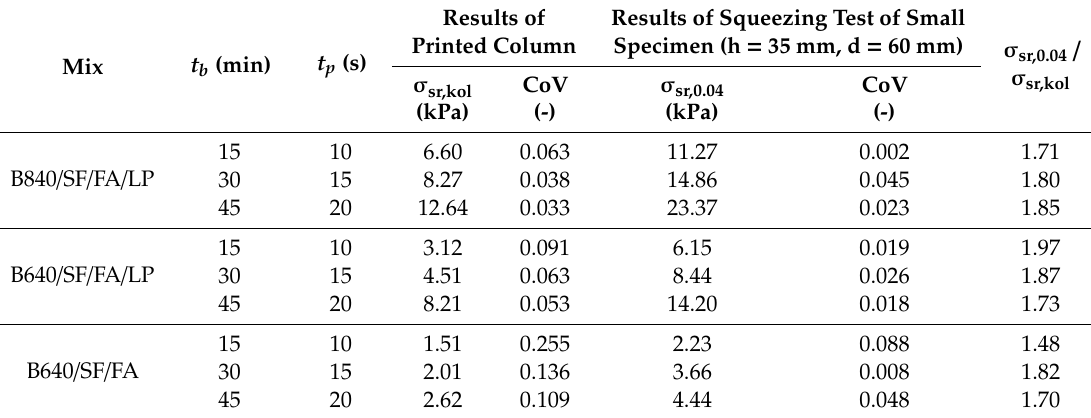
Table 6. The comparison of load-bearing capacity calculated based on the time of collapse of the columns and obtained in the printing simulation test (squeezing